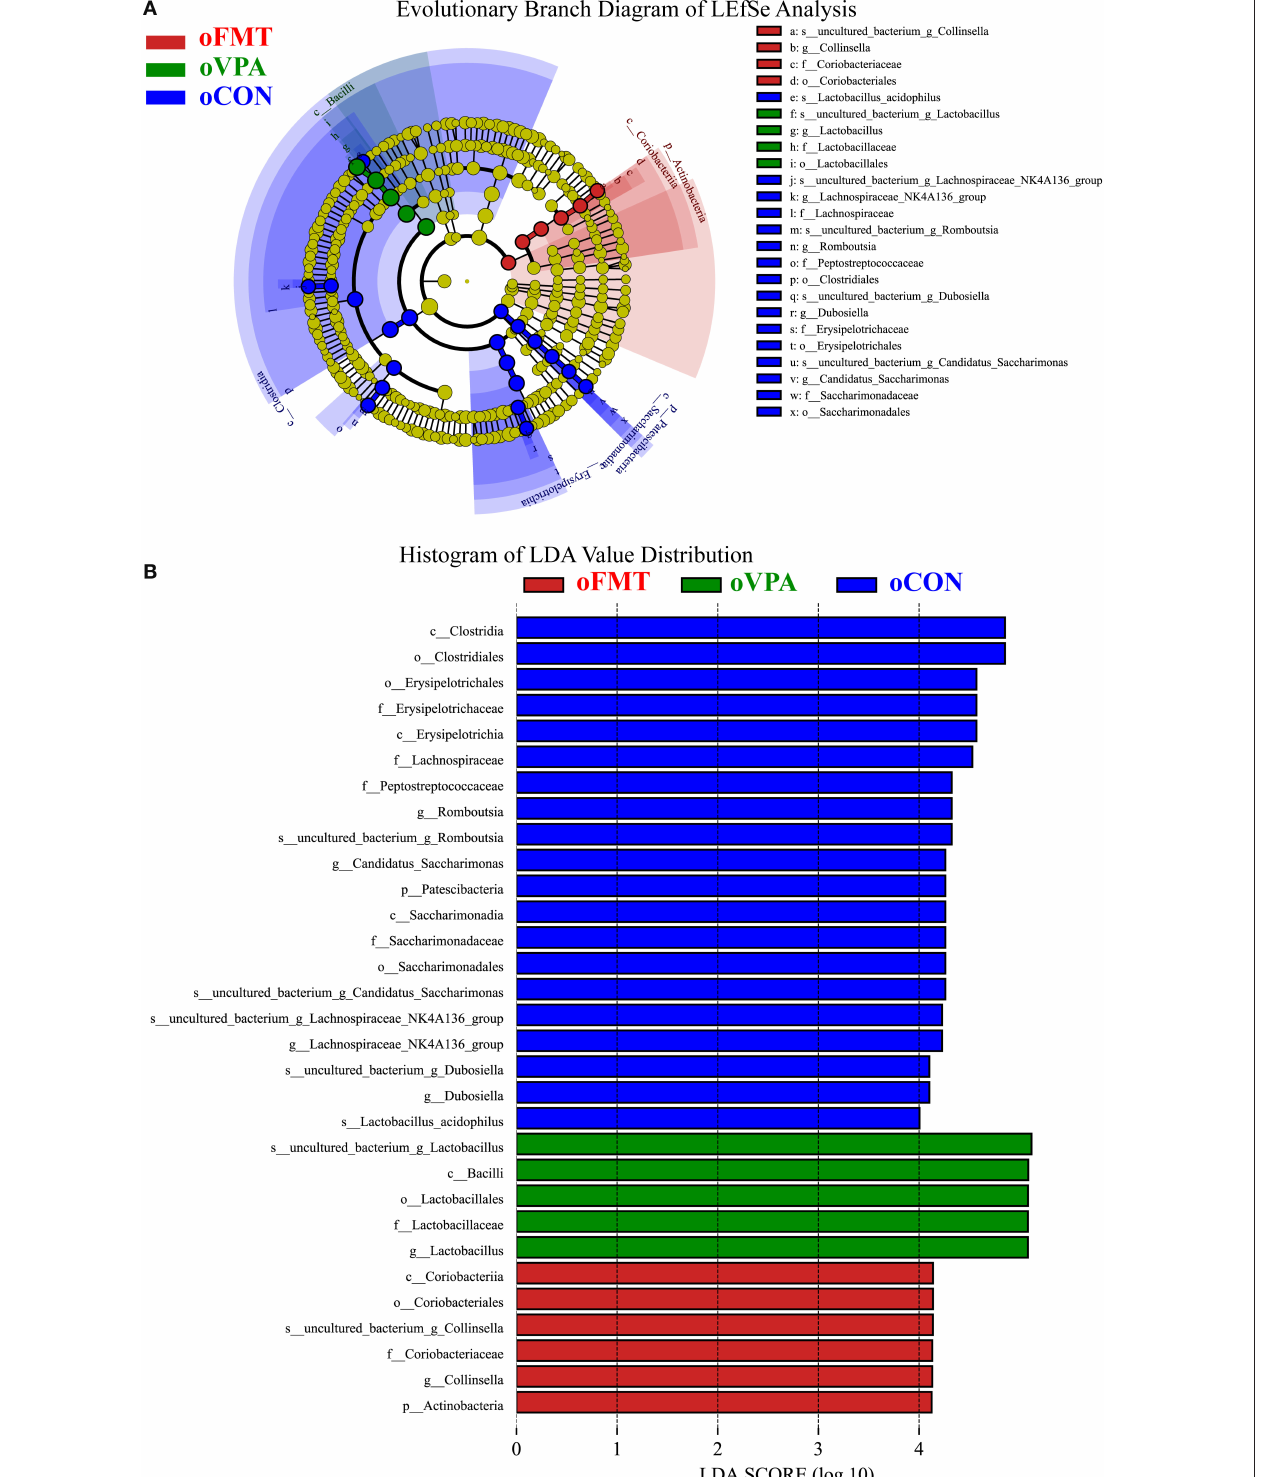
Frontiers in Psychiatry |